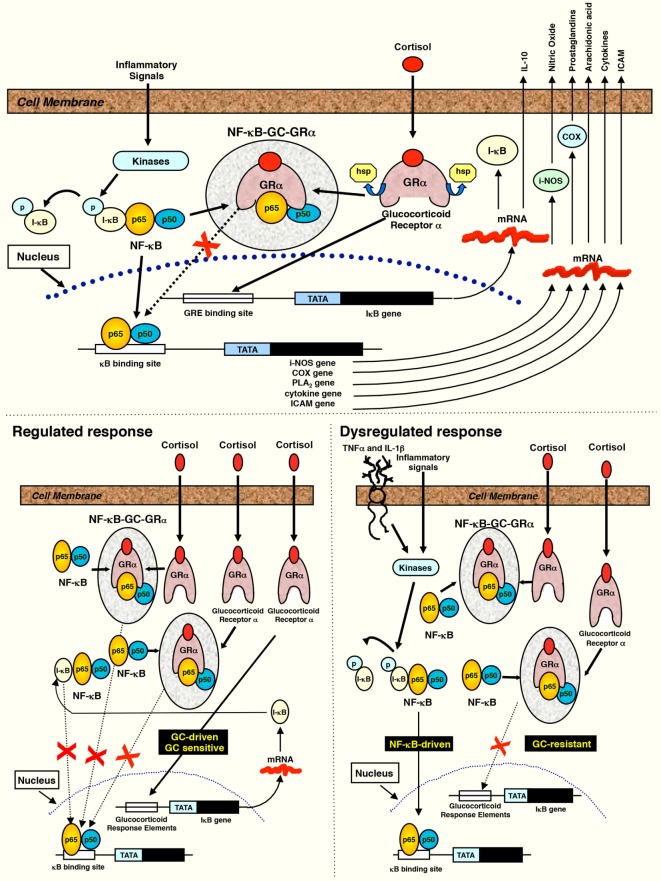
Interaction between NF-κB and the activated glucocorticoid receptor. Reproduced from Ref. (3) with permission from S. Karger AG, Medical and Scientific Publishers (Allschwilerstrasse 10, 4009 Basel, Switzerland). When cells are stimulated by inflammatory signals, specific kinases phosphorylate the inhibitory protein IκB and cause its rapid degradation. The activated form of NF-κB then moves to the nucleus initiating the transcription of mRNA of inflammatory cytokines, chemokines, cell adhesion molecules, and inflammation-associated enzymes (cyclooxygenase, phospholipase A2, and inducible nitric oxide). Cortisol or exogenous glucocorticoids freely cross into the cytoplasm and bind to their specific glucocorticoid receptors (GRα) to form the activated receptor (GC-GRα). GC-GRα complexes may influence NF-κB activity in five major ways: (1) physically interacting with the p65 subunit with formation of an inactive (GC-GRα/NF-κB) complex (4, 5), (2) inducing the synthesis of the inhibitory protein IκBα via interaction with glucocorticoid-responsive element DNA in the promoter of the IκB gene (5–7), (3) blocking degradation of IκBα via enhanced synthesis of IL-10 (8–10), (4) impairing TNF-α-induced degradation of IκBα (11, 12), and (5) competing for limited amounts of GR coactivators, such as CREB-binding protein (CBP) and steroid receptor coactivator-1 (SRC-1) (13). IκBα, in addition to holding NF-κB in an inactive cytoplasmic state (5–7), also translocates into the nucleus, where it binds activated NF-κB complexes to induce their export to the cytoplasm (4). GC-GRα may also decrease the stability of mRNA of several inflammatory cytokines and other molecules (14). Products of the genes that are stimulated by NF-κB activate this transcription factor. Thus, both TNF-α and IL-1β activate and are activated by NF-κB, by forming a positive regulatory loop that amplifies and perpetuates inflammation (15). Regulated response: GC-GRα activation sufficient to maintain NF-κB levels in homeostasis and achieve a reduction in transcription of inflammatory mediators over time is shown. In ARDS improvers, both GC-GRα binding to NF-κB and nuclear GC-GRα binding increased significantly over time, indicating an excess activation of GC-GRα compared to NF-κB (GC-GRα-driven response). Dysregulated response: an excess of NF-κB activation is shown, leading to protracted transcription of inflammatory mediators over time. In ARDS non-improvers, GC-GRα binding to NF-κB was modestly increased while nuclear NF-κB binding increased substantially over time and nuclear GC-GRα and cytoplasmic IκBα levels declined (NF-κB-driven response).